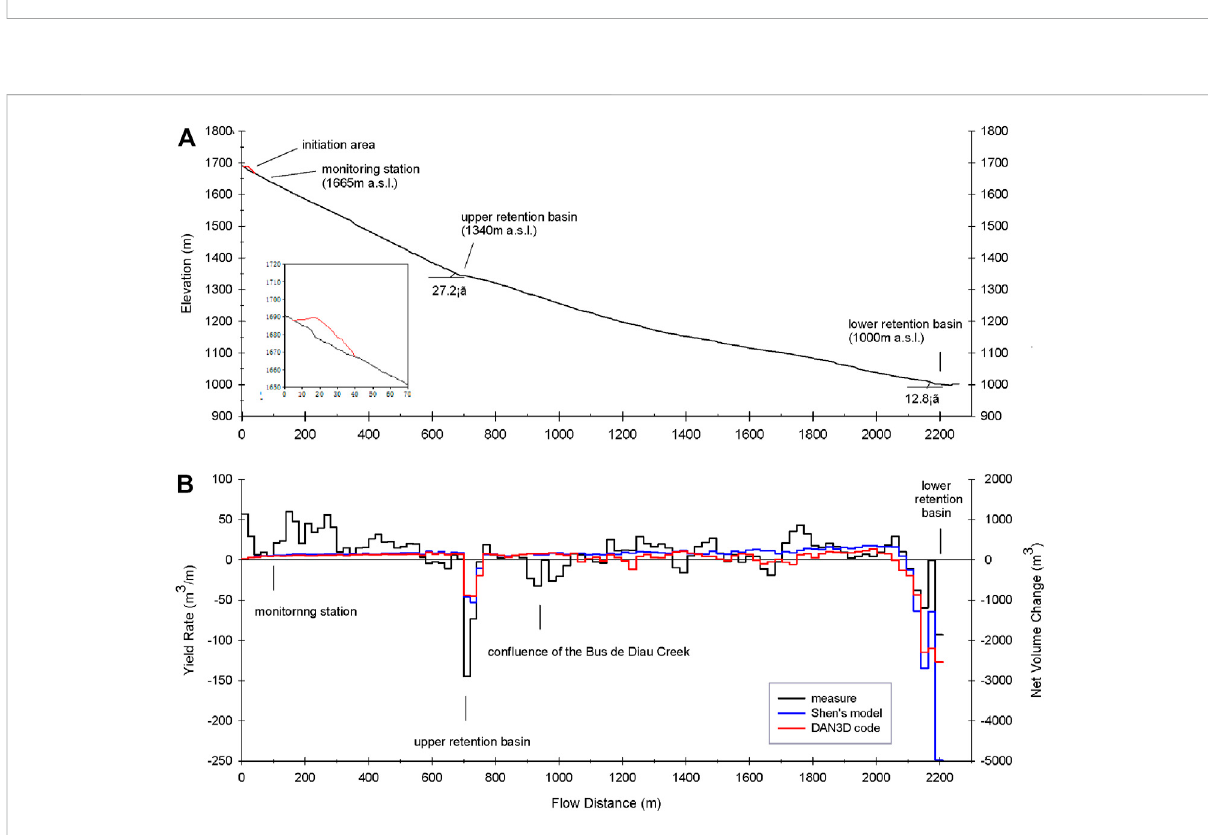
FIGURE 12 Variation of (A) elevation and (B) net volume along the fl ow